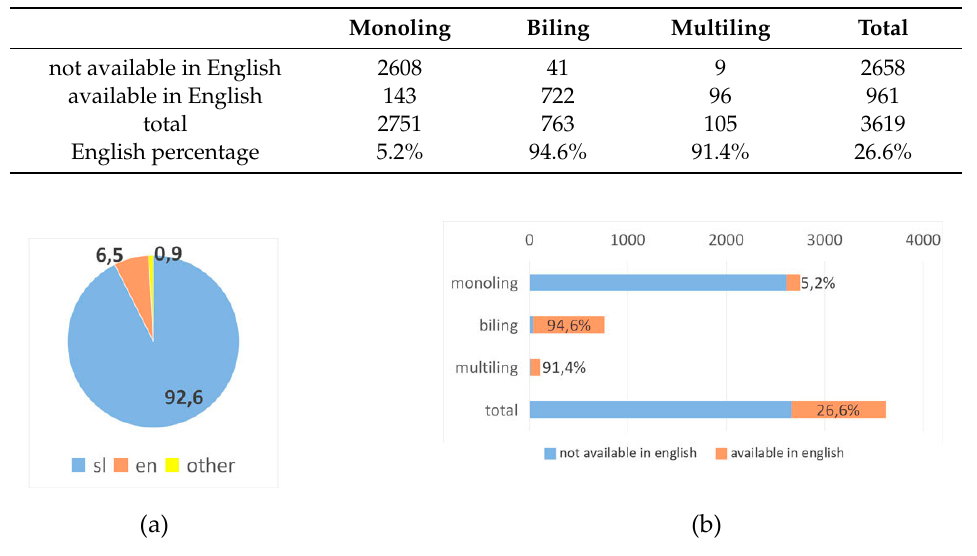
language availability bar chart.